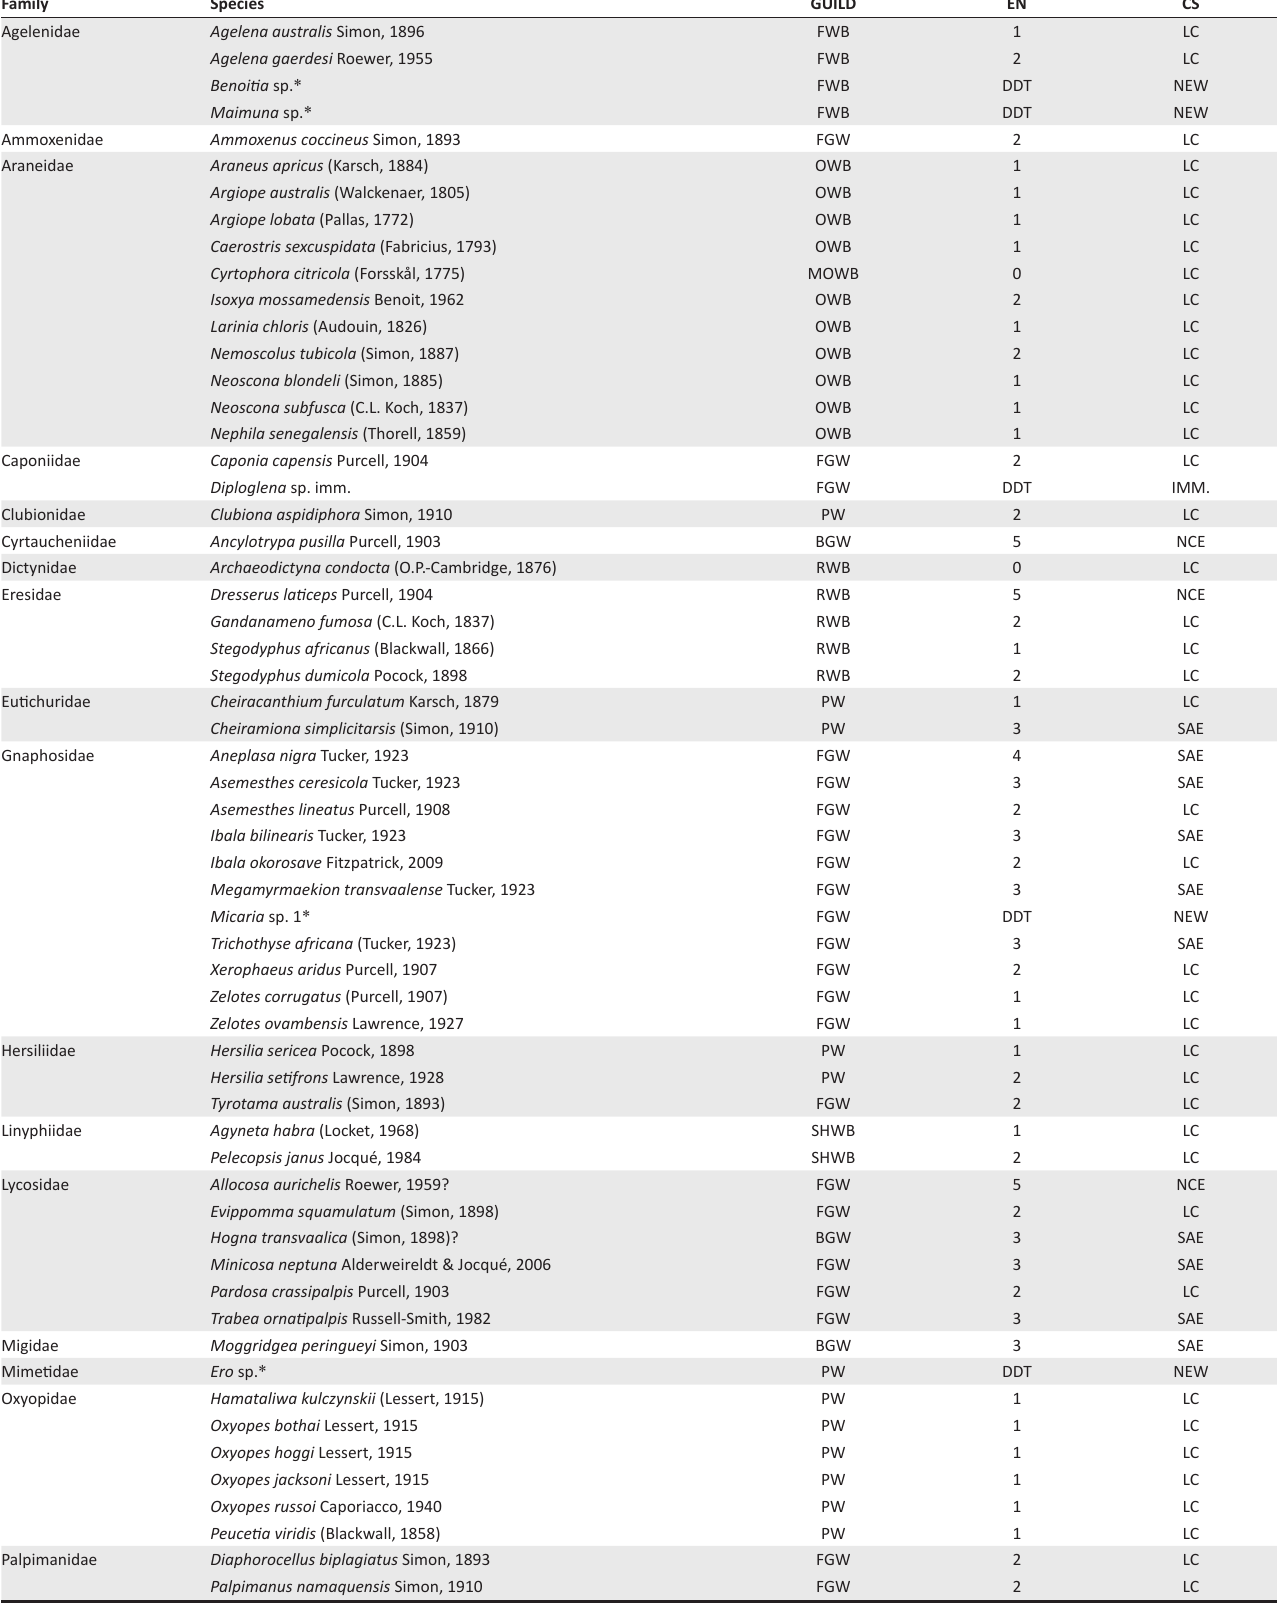
TABLE 1-A1: Checklist of the spiders of Tswalu Kalahari Reserve with guild, endemicity (EN) and conservation status (CS). Family Species Agelenidae